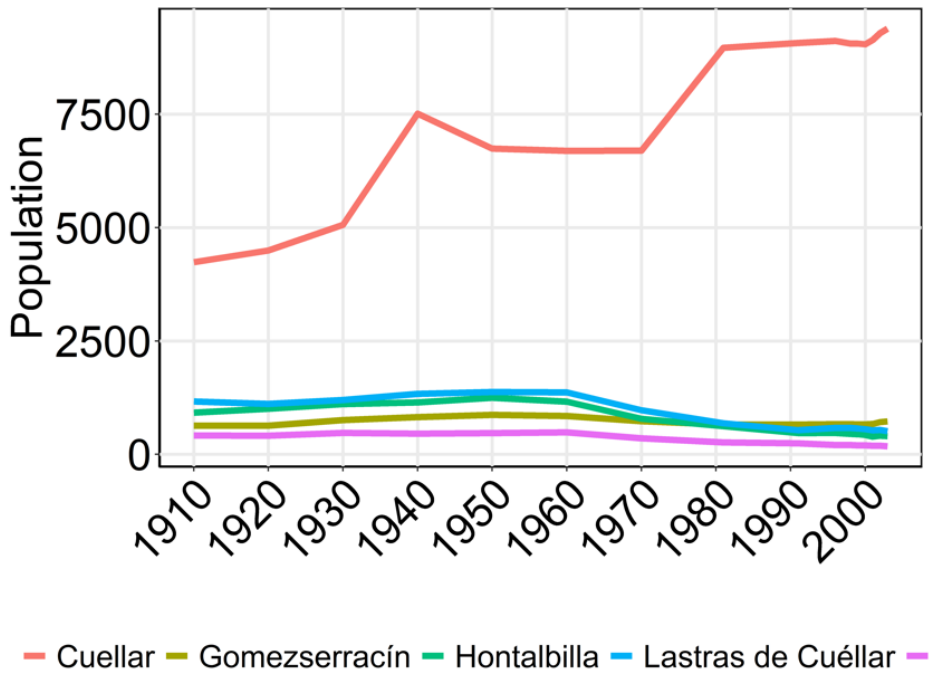
Figure 4. Population trends (number of inhabitants per village) of the five villages that own the forest.